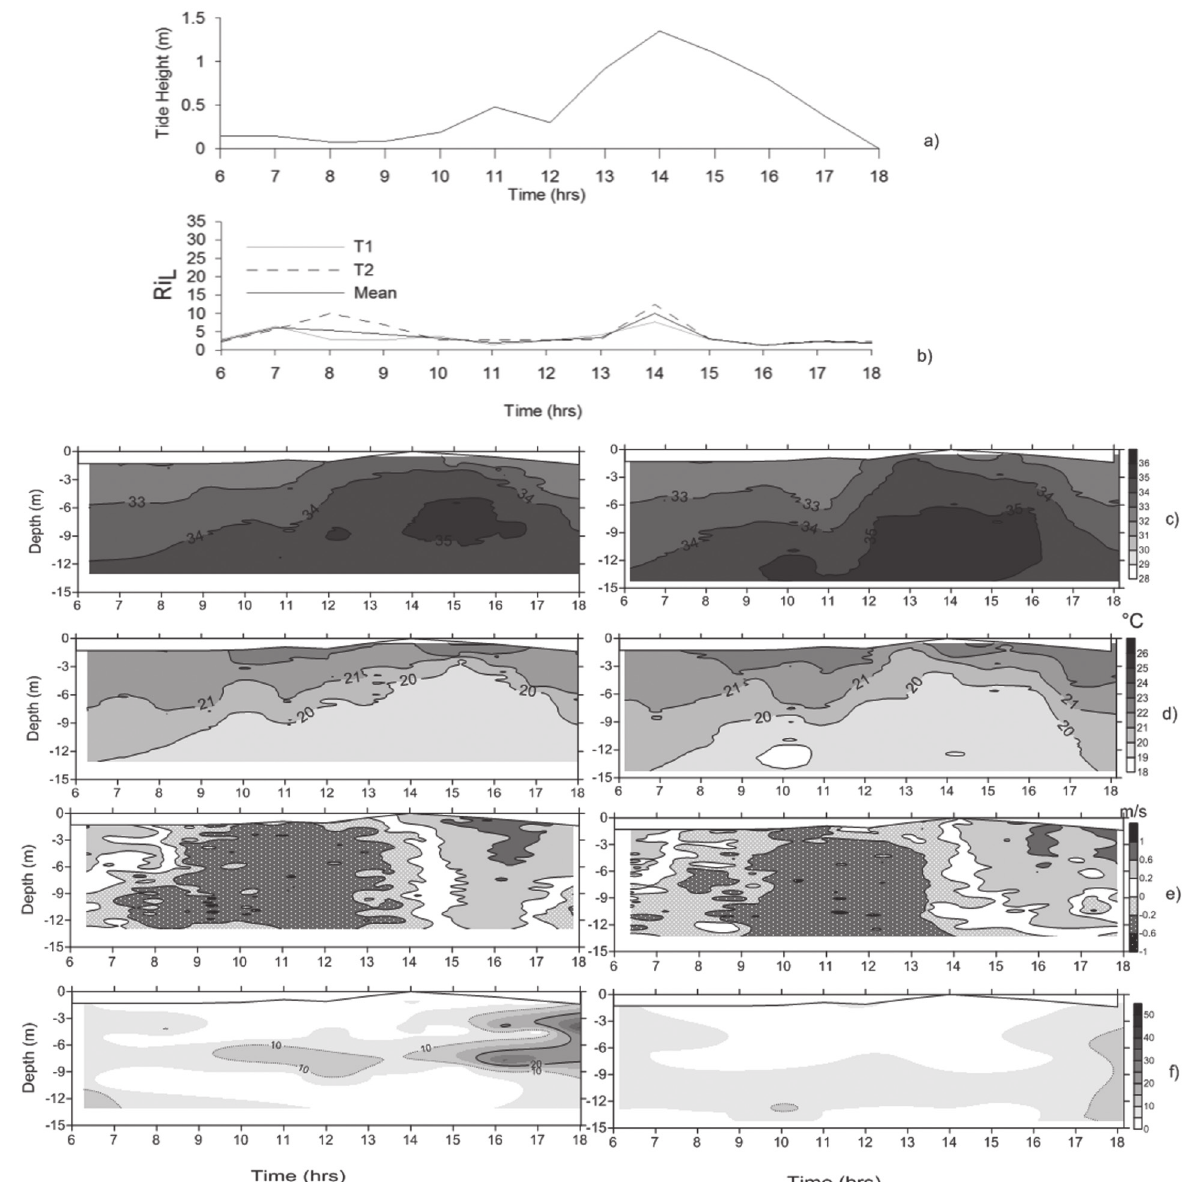
Figure 5 - Temporal profiles of SC (spring cycle during the rainy season - 12/03/2010); a) tide elevation (m); b) Layer Richardson number; c) salinity (PSU) d) temperature (°C); e) longitudinal velocity (m/s); f) SPM (mg/L); .Left column is station T1 and right column station